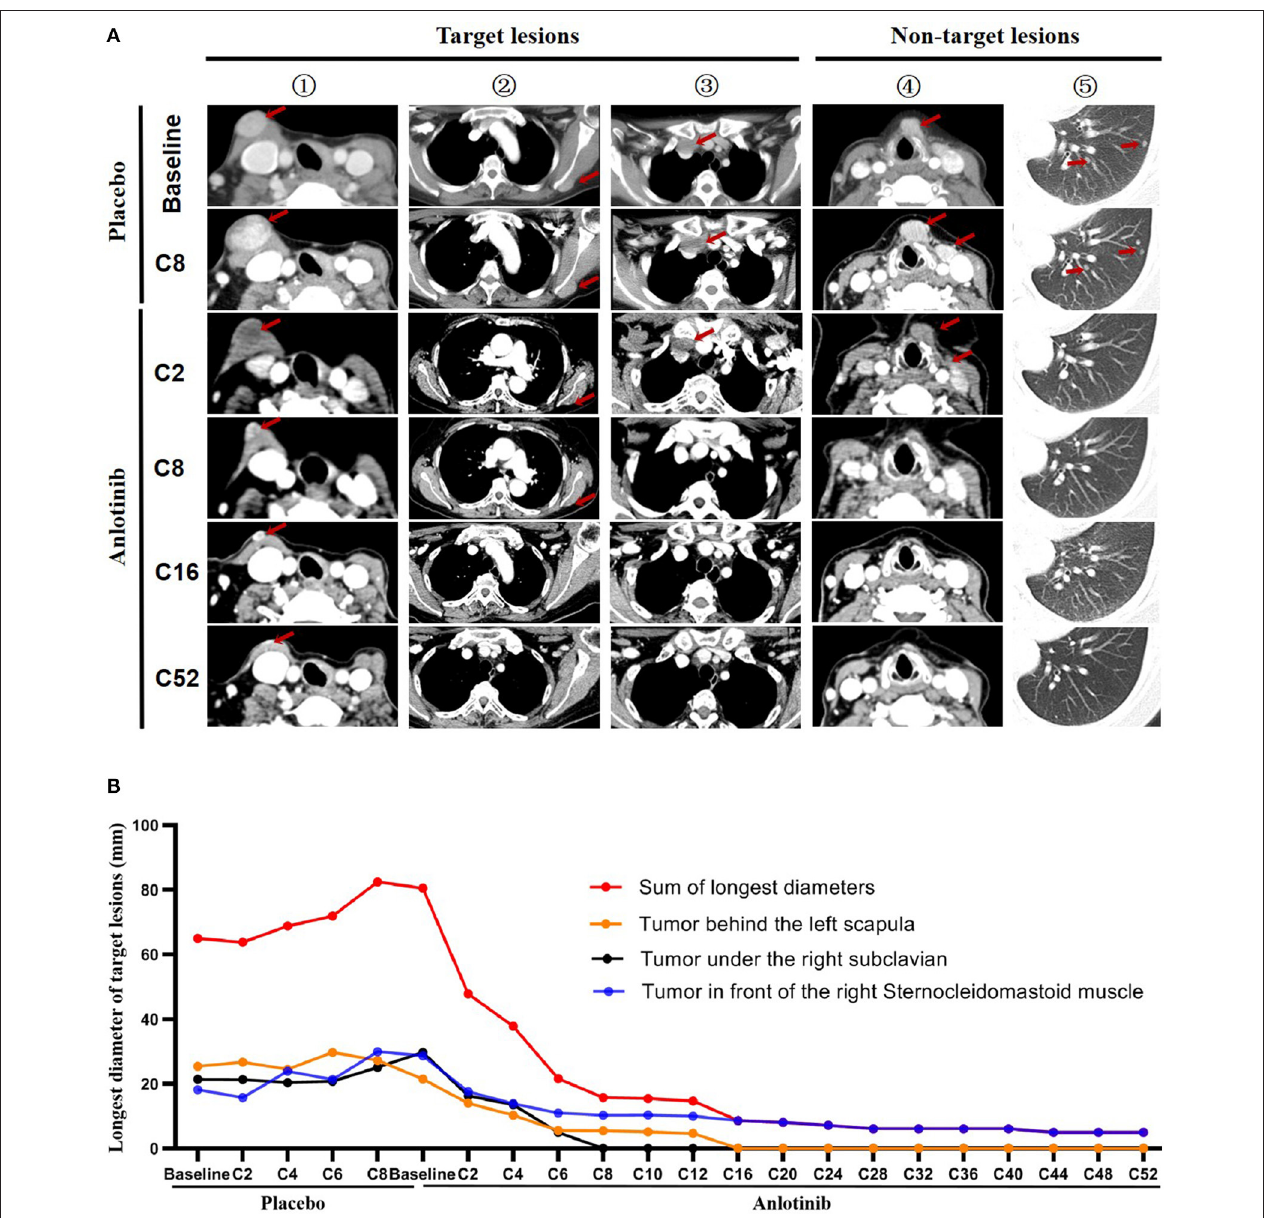
FIGURE 2 | Tumor shrinkage during placebo and anlotinib therapy. (A) Imaging evaluation on target and non-target lesions, including placebo therapy (baseline, C2, C8) and anlotinib therapy (baseline, C2, C8, C16, and C52). ( ‹ : Tumor under the right subclavian; › : Tumor in front of the right sternocleidomastoid muscle; fi : Tumor behind the left scapula; fl : Tumor in front of larynx and tumor in the cervical sheath; (cid:176) : Metastatic tumor of the left lung). Red Arrow: tumor. (B) Tumor shrinkage per review (Evaluation was performed before C12 in every two cycles and after C12 in every four cycles).